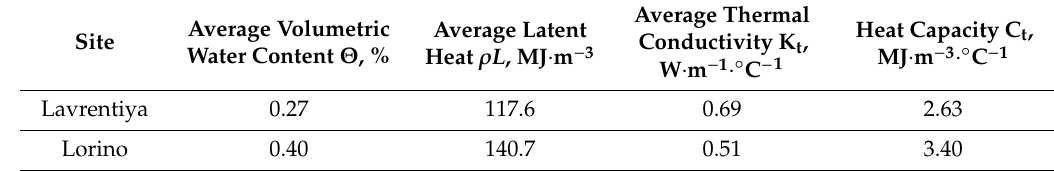
Table 6. Thermal properties of the active layer used in the calculations with Equations (4)–(6).